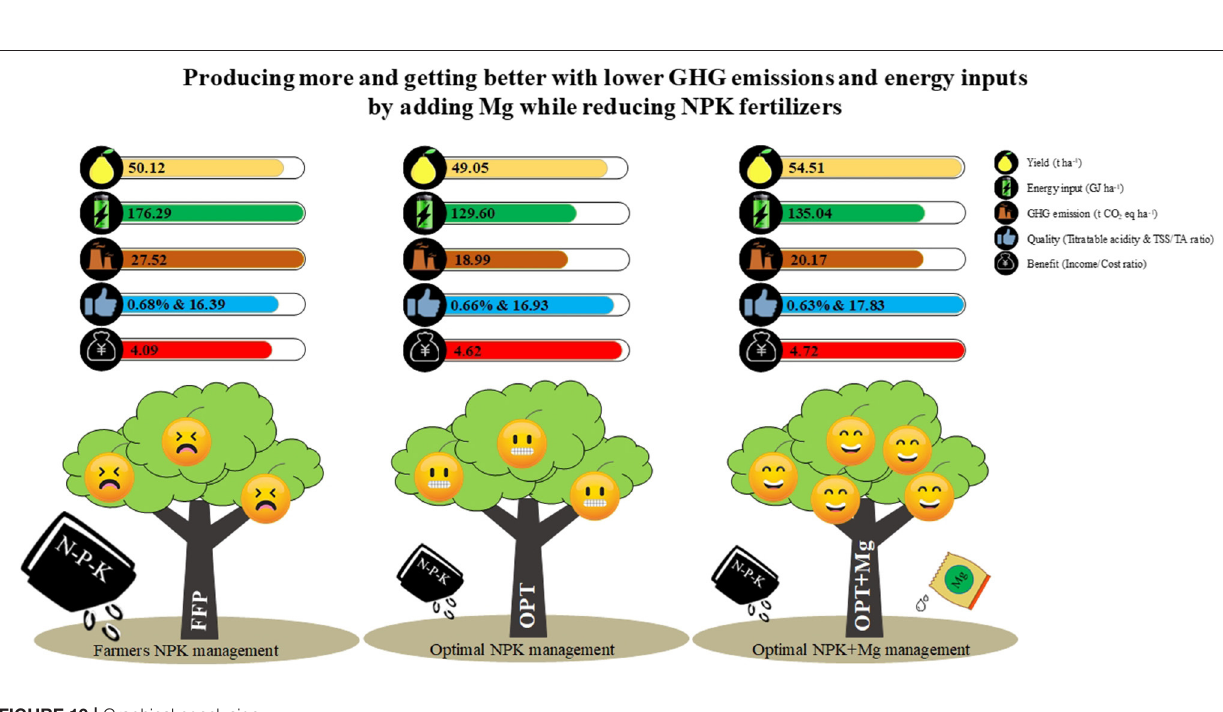
FIGURE 10 | Graphical